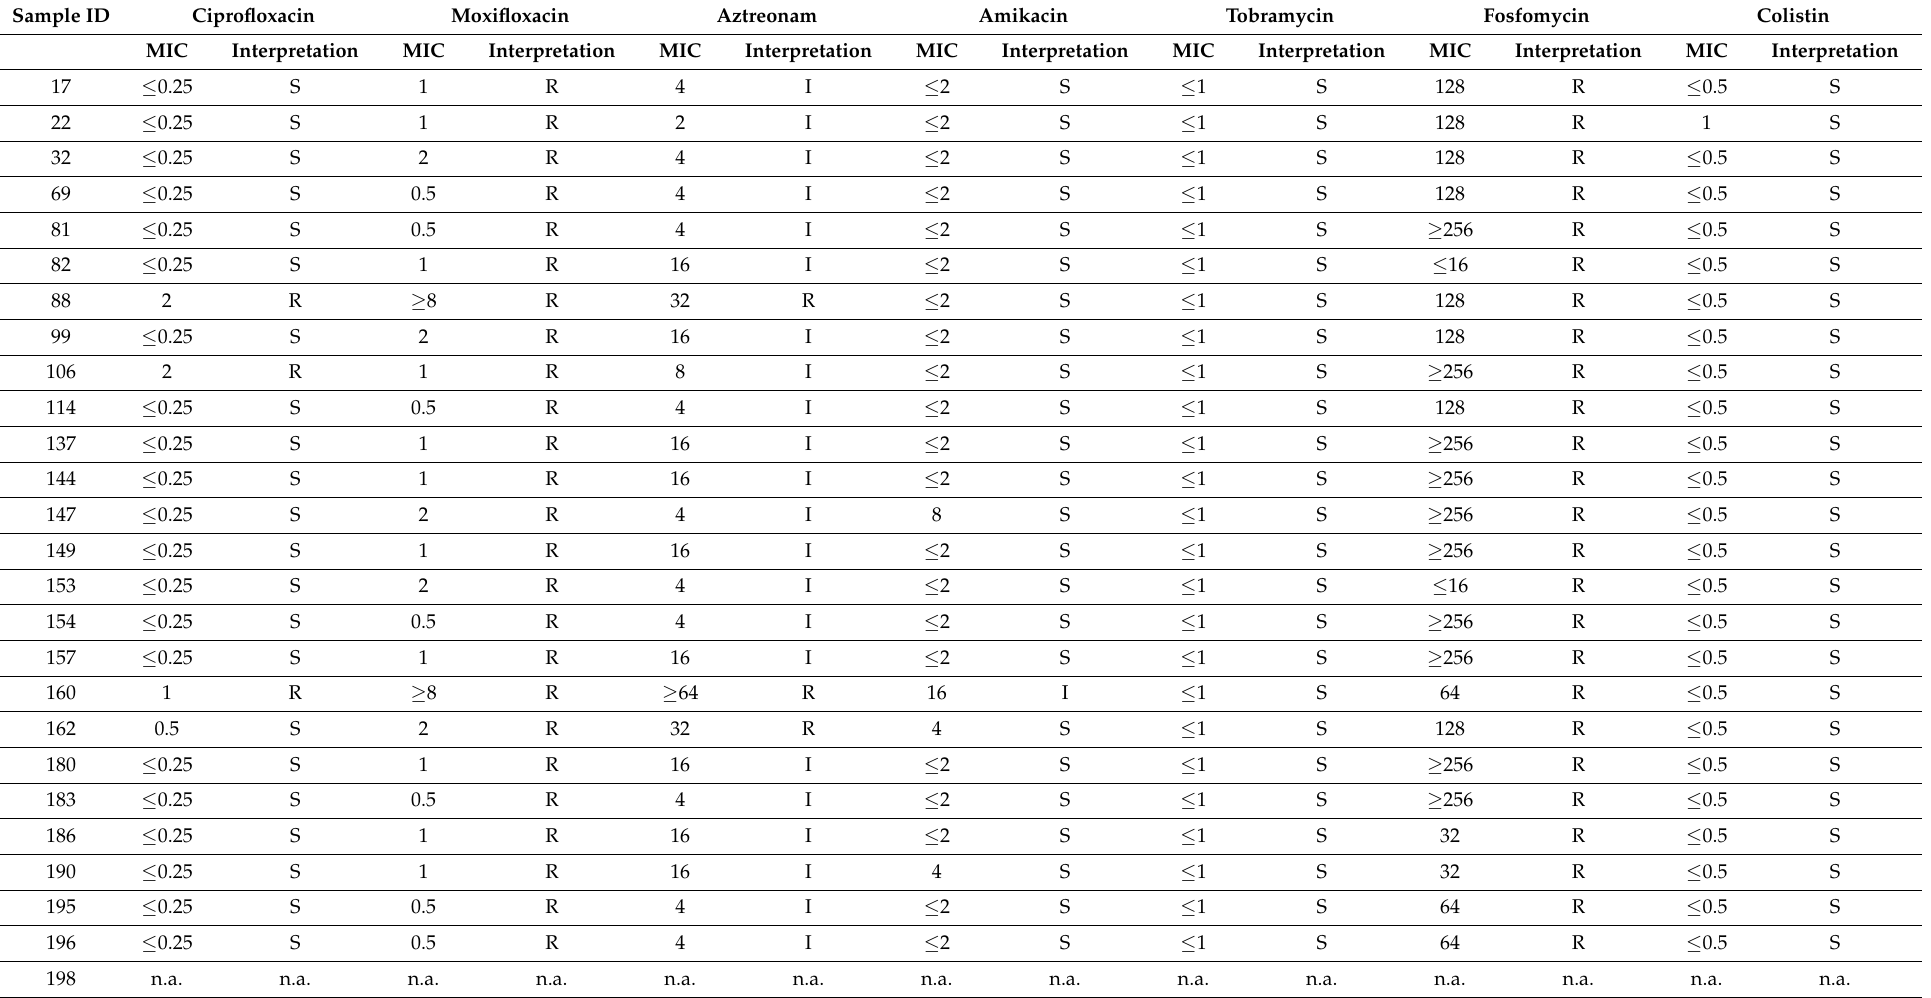
Table A4. Phenotypic resistance of P. aeruginosa strains. Data are missing for strains 198, 218 and 312 due to loss during subcultivation. MIC = minimum inhibitory concentration. N.a. = value missing due to loss of strain or failed